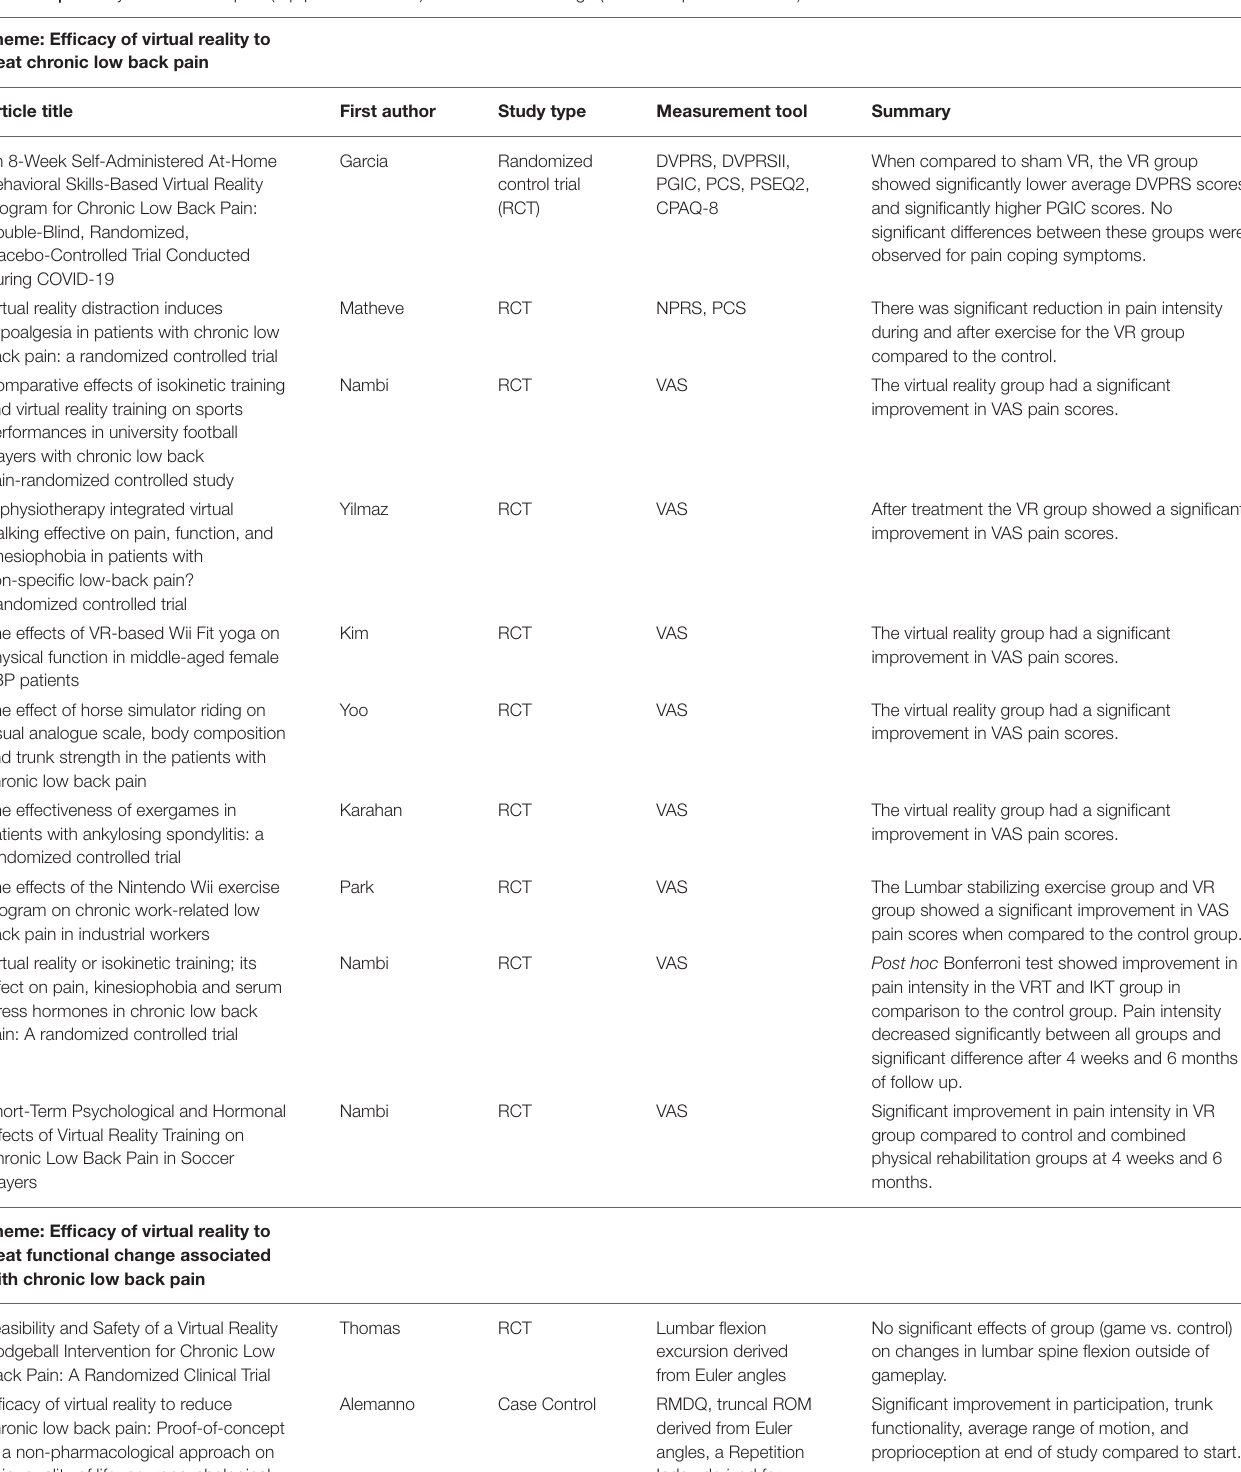
TABLE 2 | Efficacy of VR to treat pain (top portion of Table) and functional change (bottom of portion of Table) associated with CLBP. Theme: Efficacy of virtual reality to treat chronic low back